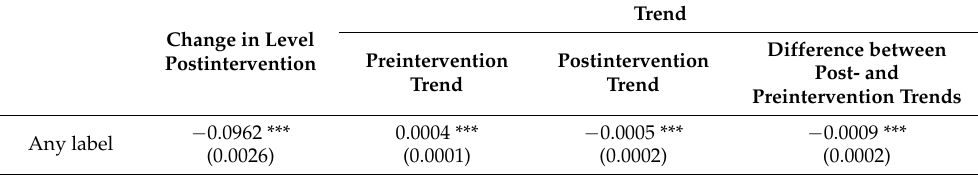
Table 3. Marginal effect on budget shares and trends before and after the intervention.